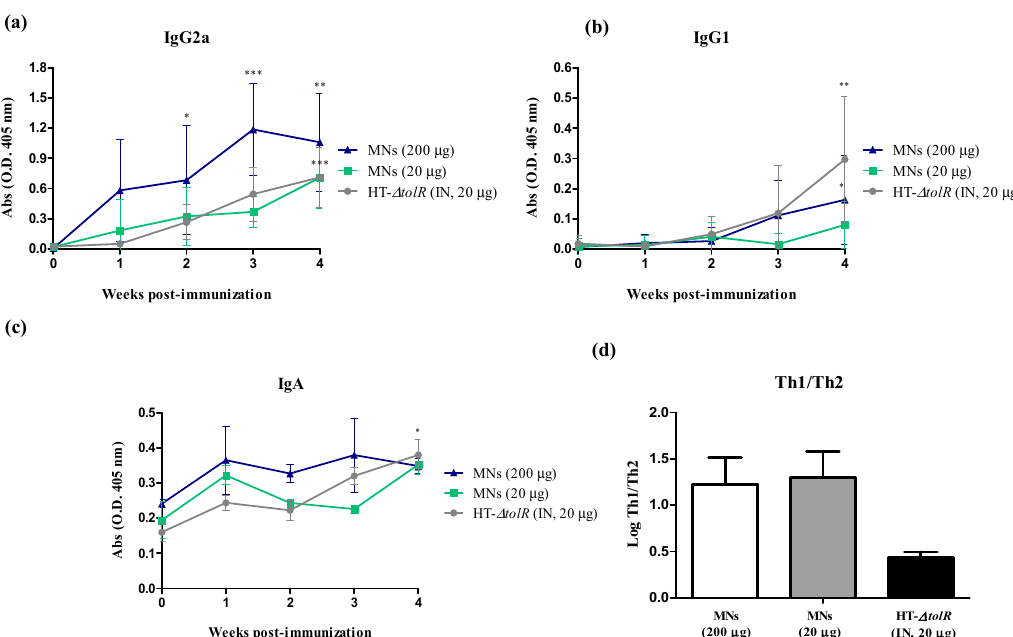
Figure 7. Antibody immune response induced after skin vaccination of BALB / c mice with free HT- ∆ tolR or embedded in Gantrez ® AN119 microneedles. Specific serum IgG2a ( a ) and IgG1 ( b ) or fecal IgA ( c ) against HT- ∆ tolR in immunized BALB / c mice with 20 µ g of HT- ∆ tolR or embedded in MNs (20 or 200 µ g) (*, p < 0.05, **, p < 0.01, ***, p < 0.001, versus time 0). Blood and fecal samples were taken from week 0 to 4 week after immunization. The balance of Th1 / Th2-immune response ( d ) is represented by the logarithm (Log) of the relative expression levels of IgG2a / IgG1 absorbance at week 4 post-immunization. Error bars represent SD.